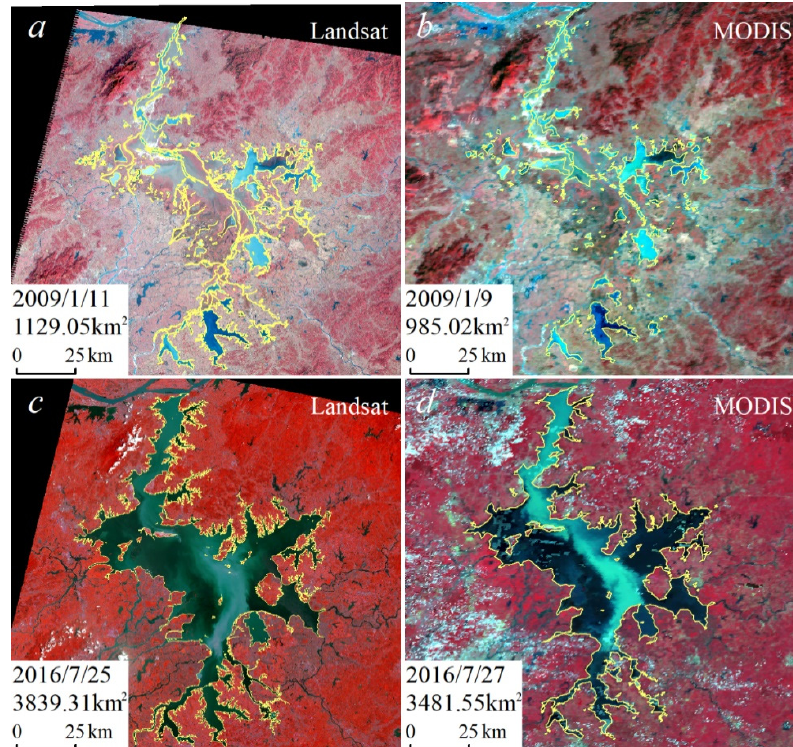
Figure 13. Comparison of 30 m interpretation products and the extracted extents based on MODIS images. ( a , b ) indicate water boundaries extracted from Landsat and MODIS images in 2009. ( c , d ) separately indicate Landsat and MODIS results in 2016.